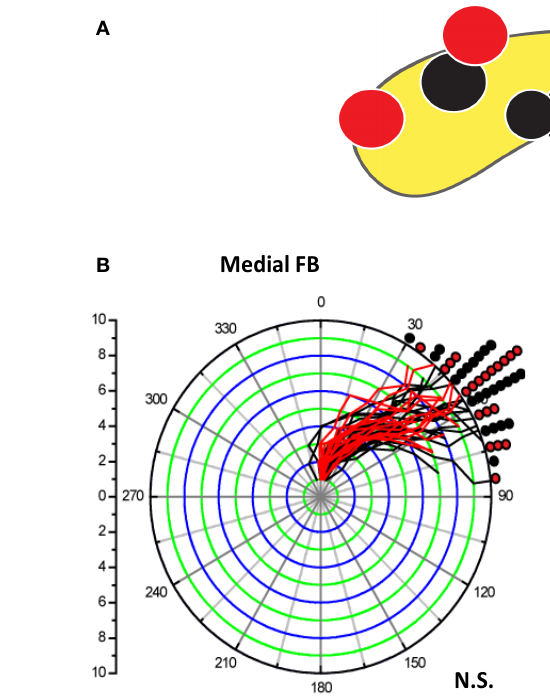
FIGURE 6 | Lateral lesions in the FB affected turning behavior in a U-shaped track, but medial lesions in the FB did not. (A) . Location of lesions within the FB. Black dots showed no significant change in turning behavior between pre-tests and post-lesion trials. Red dots indicate lesions that produced 2SD changes in the behavior between pre-test and post-lesion trials. (B,C) compare turning behavior of all pre- and post-lesion trials. For each trial, the change in turning angle of the cockroach body was measured relative to the position at antennal contact (plotted at the center of the polar plot) and at each subsequent step (annuli) made by the middle legs. Regardless of the direction of movement, curves that bend to the right indicate turns in the expected direction (away from the side-wall).